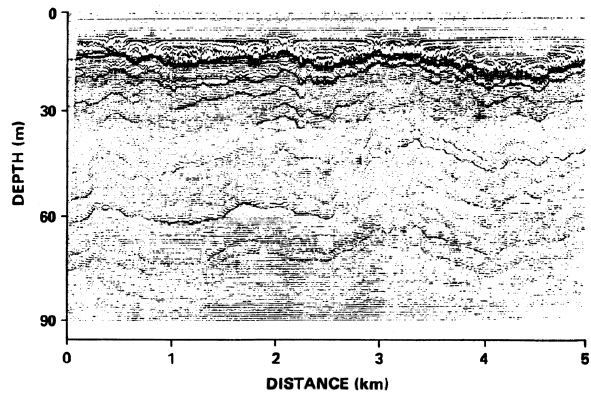
Fig. 16. Two-dimensional plot of vertical temperature gradient in the ocean from the surface to about 90m using a towed vertical ar- ray of sensors separated by 50cm. The dark regions correspond to high temperature gradients. They exhibit large horizontal scales (sometimes more than 1km) and large-scale vertical displacements. It is difficult to obtain information on these displacements at a small-scale from this figure (after Dugan,